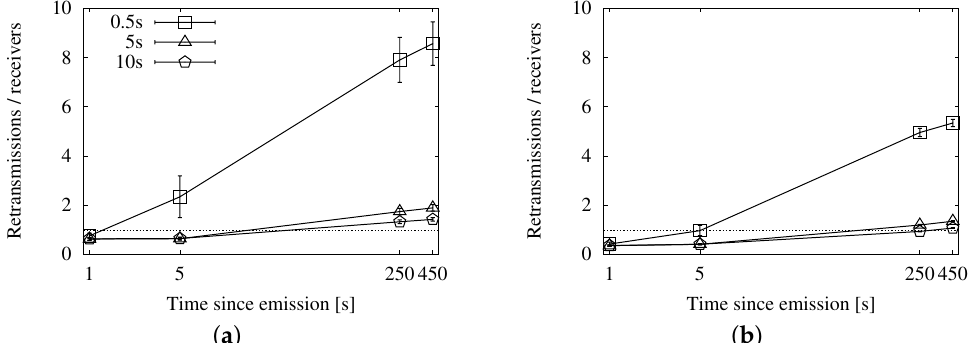
Figure 12. Forwarding ratio or the relation between sent messages and receivers with the fixed interval approach for store-carry-forward in the New York scenario: ( a ) roadway scheme, 25 vehicles/km 2 ; ( b ) roadway scheme, 100 vehicles/km 2